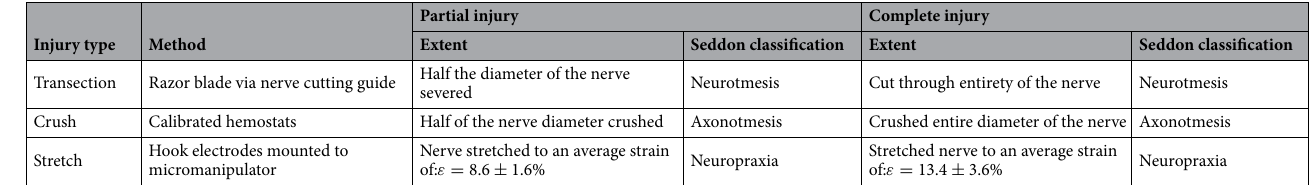
Table 1. Examined nerve injuries, methods, extent, and Seddon classification*. *Seddon 58 and Seddon et al. 59